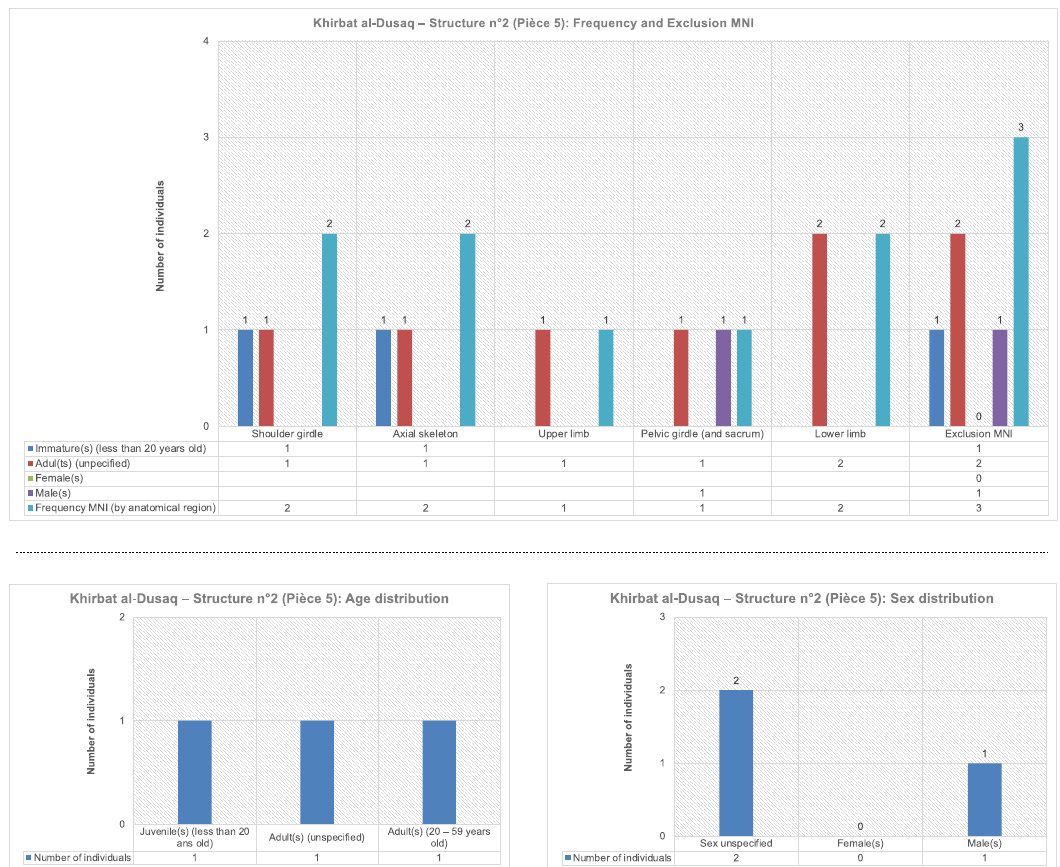
Figure 9: Structure no 2 ( Pièce 5 ) frequency and exclusion MNI graph ( top ) , age distribution graph ( bottom left ) , and sex distribution graph ( bottom right ) . Figures by Hofstetter ( 2022 )